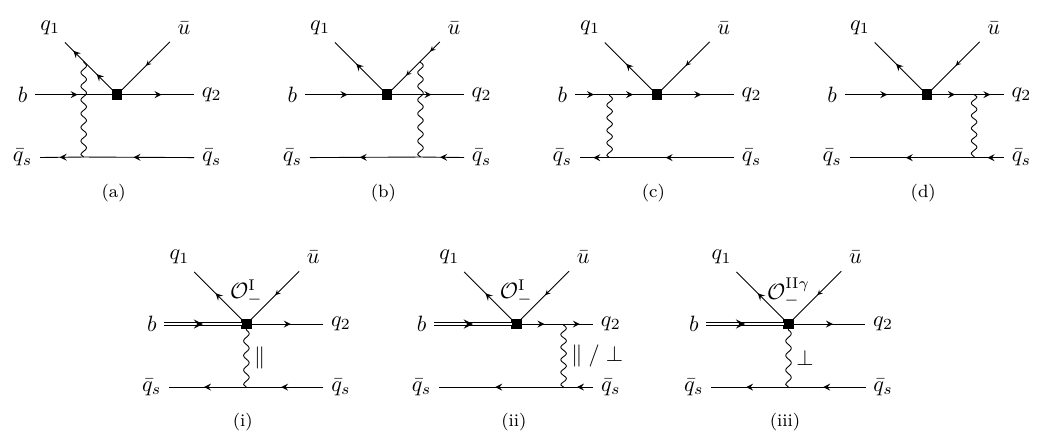
Figure 6 . Tree-level spectator-scattering in the full theory and in SCET I